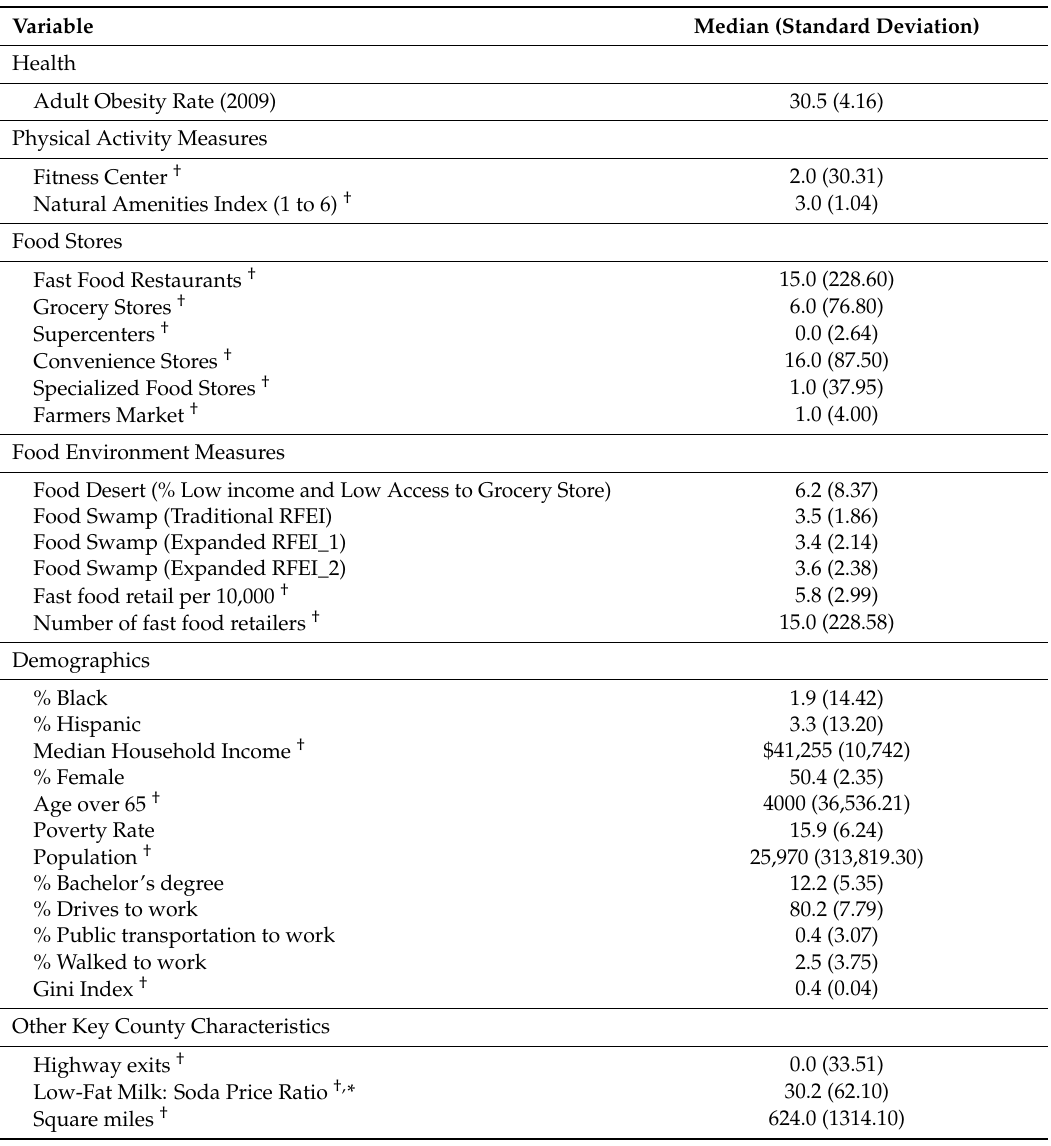
Table 3. Descriptive Statistics for all Counties in the United States ( N =